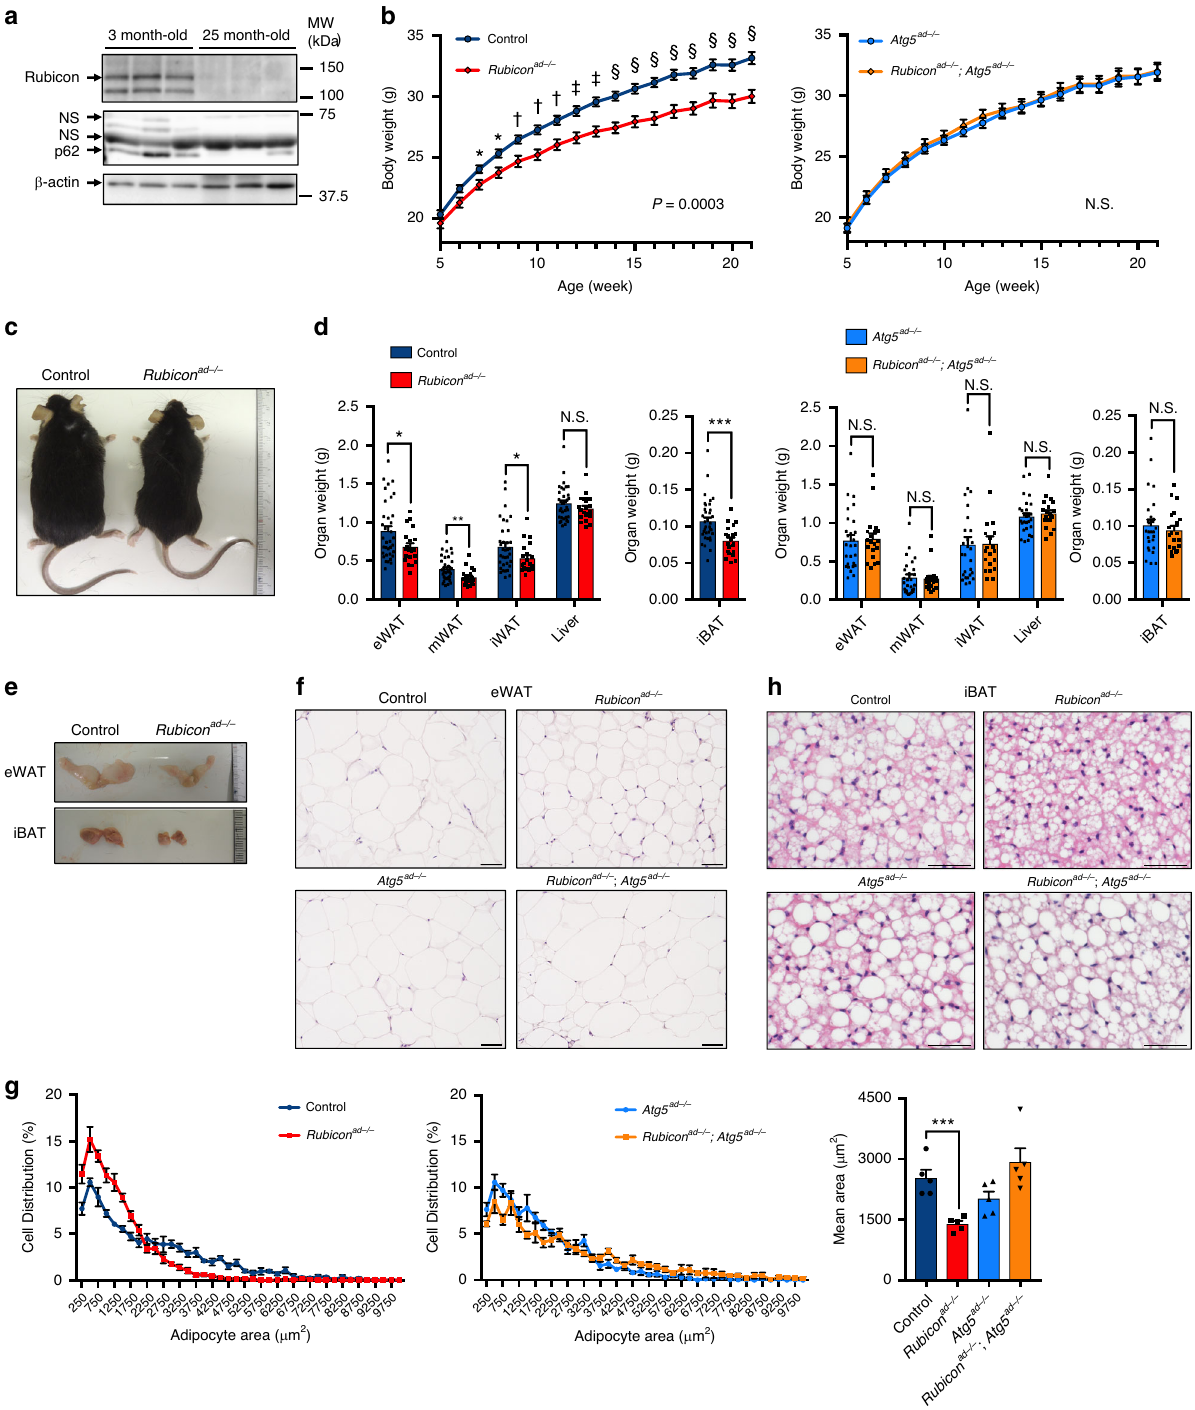
Fig. 1 Loss of Rubicon in adipocytes causes a reduction in body weight and adipose tissue mass. a Immunoblotting to detect Rubicon and p62 in the eWAT depots of 3- or 25-month-old wild-type mice on an NCD. n = 3 mice. b Body weight chart for mice of the indicated genotypes on an NCD. Intraperitoneal glucose tolerance test (IPGTT) (Fig. 2c) and intraperitoneal insulin tolerance test (IPITT) were performed at 17 and 19 weeks, respectively. Control, n = 35; Rubicon ad − / − , n = 21; Atg5 ad − / − , n = 27; Rubicon ad − / − ; Atg5 ad − / − , n = 20. c Representative image of a 21-week-old control and Rubicon ad − / − mouse on an NCD. d Organ weight of eWAT, mWAT, iWAT, iBAT and liver from 21-week-old mice of the indicated genotypes, described in ( b ). Control, n = 35; Rubicon ad − / − , n = 21; Atg5 ad − / − , n = 27; Rubicon ad − / − ; Atg5 ad − / − , n = 20. e Representative images of fat pads from a 21-week-old control and Rubicon ad − / − mouse on an NCD. f , h Representative images of H&E staining of eWAT ( f ) and iBAT ( h ) sections from mice of the indicated genotypes on an NCD. Scale bars, 50 μ m. n = 5 mice with similar results. g Distribution of adipocyte area in the eWAT sections in f . n = 5 mice. Quanti fi cation of mean adipocyte area is shown in the graphs at right. Error bars indicate means ±SEM. Data were analysed by two-tailed Student ’ s t test ( d , g ) or two-way repeated- measures ANOVA followed by Fisher ’ s LSD test ( b ). P value from left to right: 0.0003, 0.7257 ( b ), 0.0258, 0.0067, 0.0494, 0.2337, 0.0005, 0.8217, 0.8418, 0.9407, 0.5023, 0.5205 ( d ), 0.0008 ( g ). * P <0.05; ** or † P <0.01; *** or ‡ P < 0.001; § P <0.0001. N.S. not signi fi